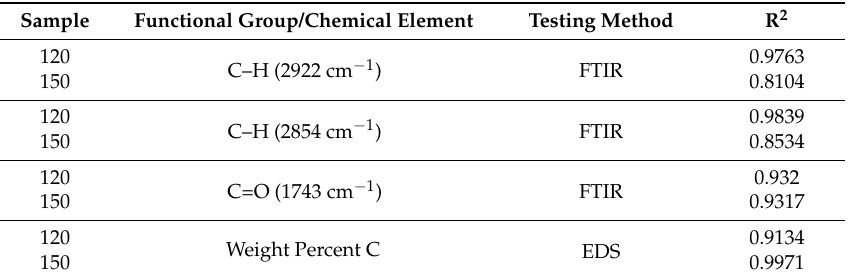
Table 6. Correlation between DP and functional group/chemical element of transformer insulation paper.